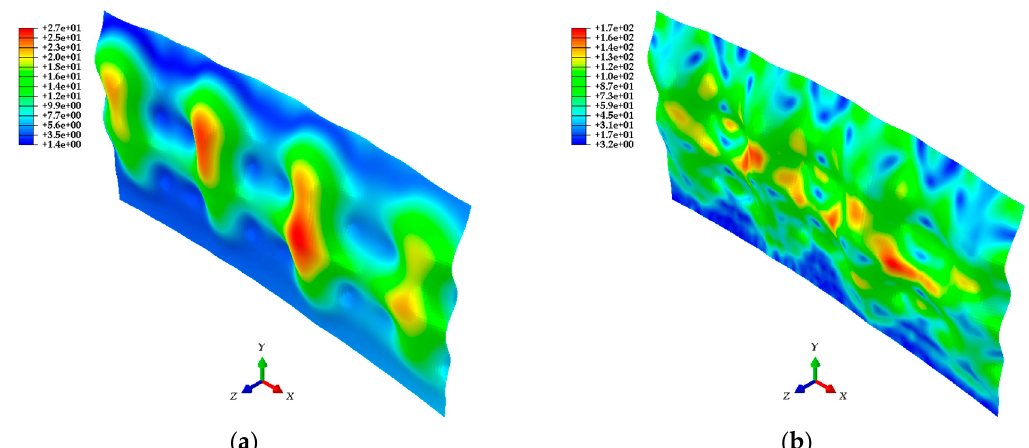
Figure 17. Displacement and stress distribution of the finite element model: ( a ) Distribution of the absolute displacement [Unit: mm ]; ( b ) Distribution of the von Mises stress [Unit: MPa ].